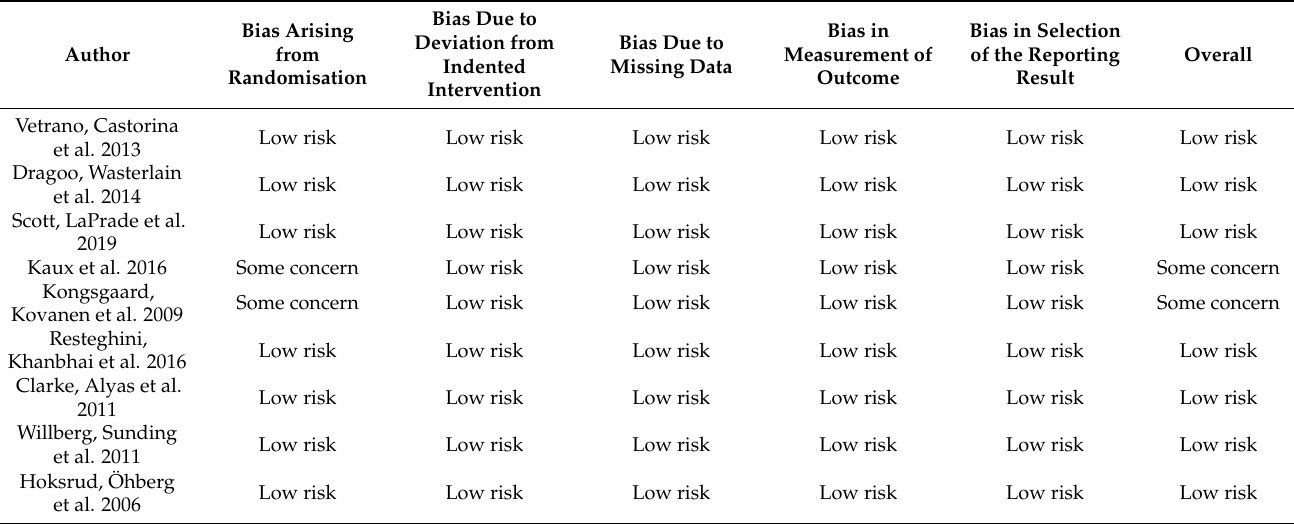
Table 2. Risk bias assessment of the included studies.